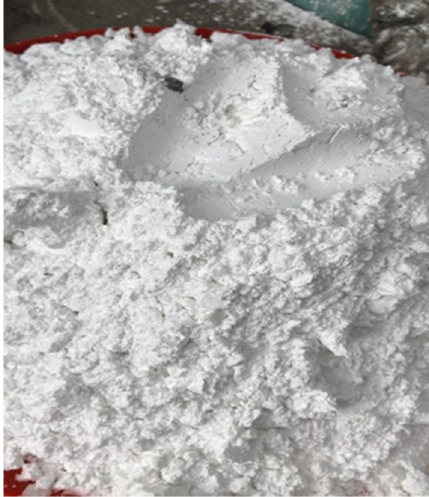
Table 3. Dehumidifier indicators.